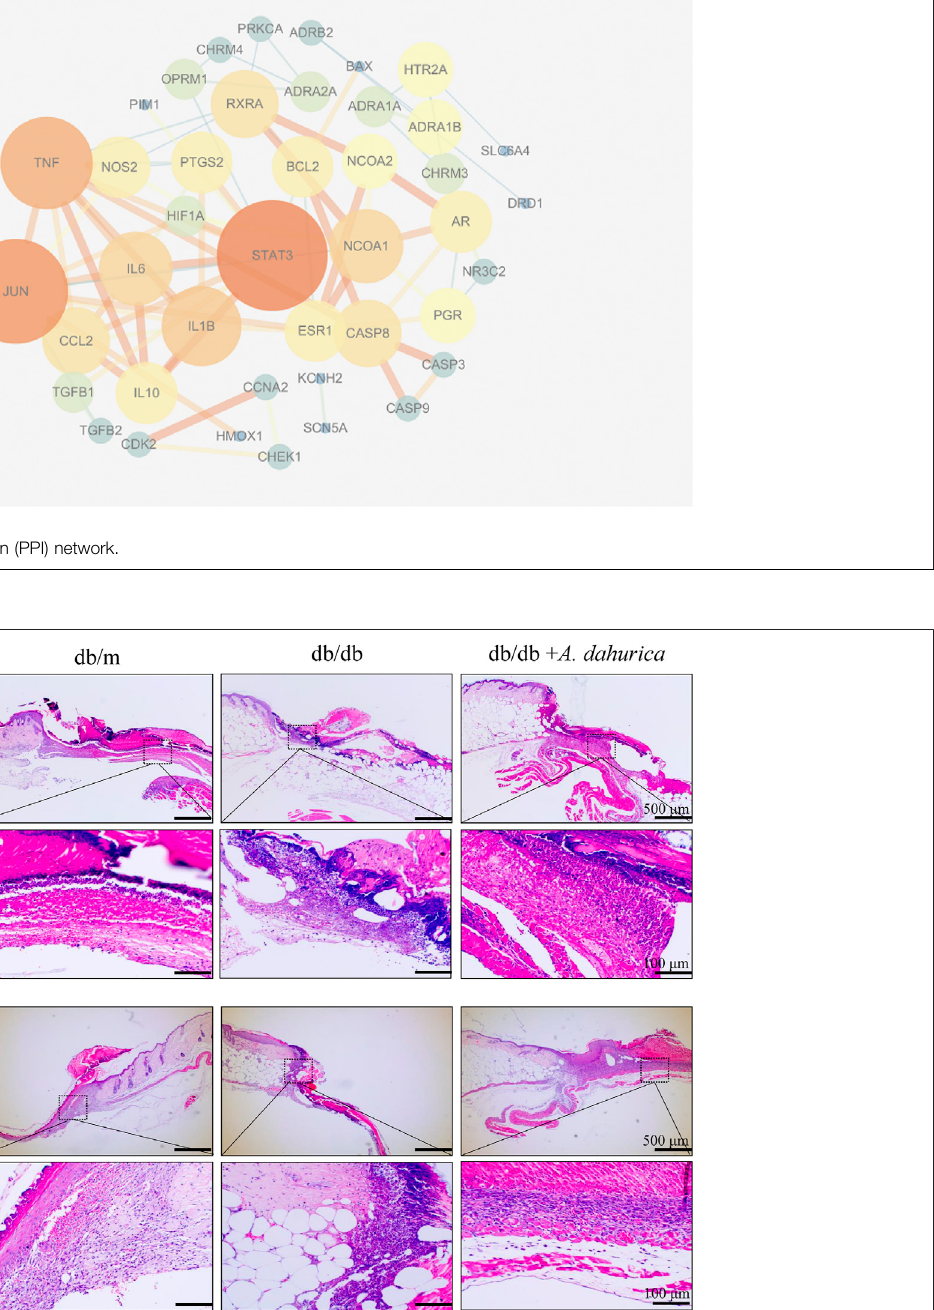
Frontiers in Pharmacology |